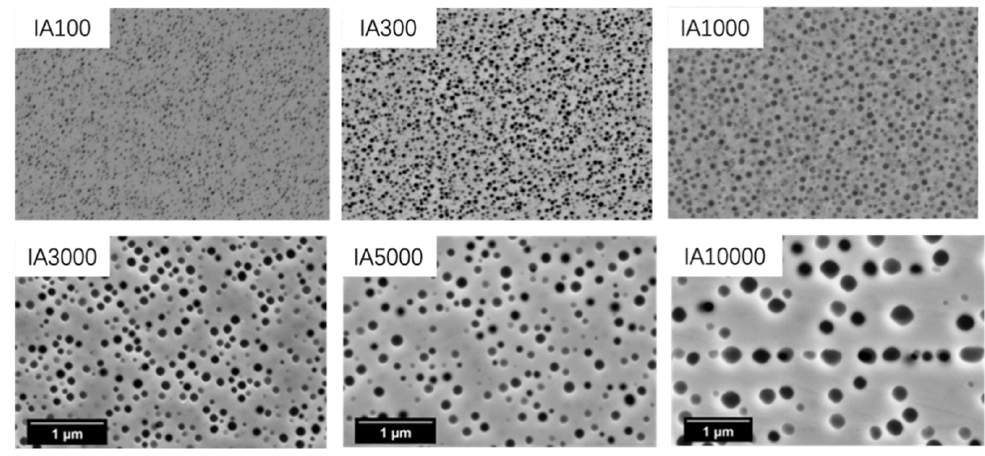
Figure 12. Micrographs of γ ’ particles in different isothermal aging samples.